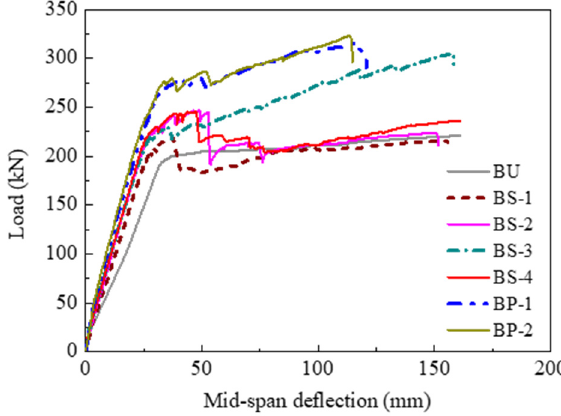
Figure 7. Comparisons of load–deflection curves.